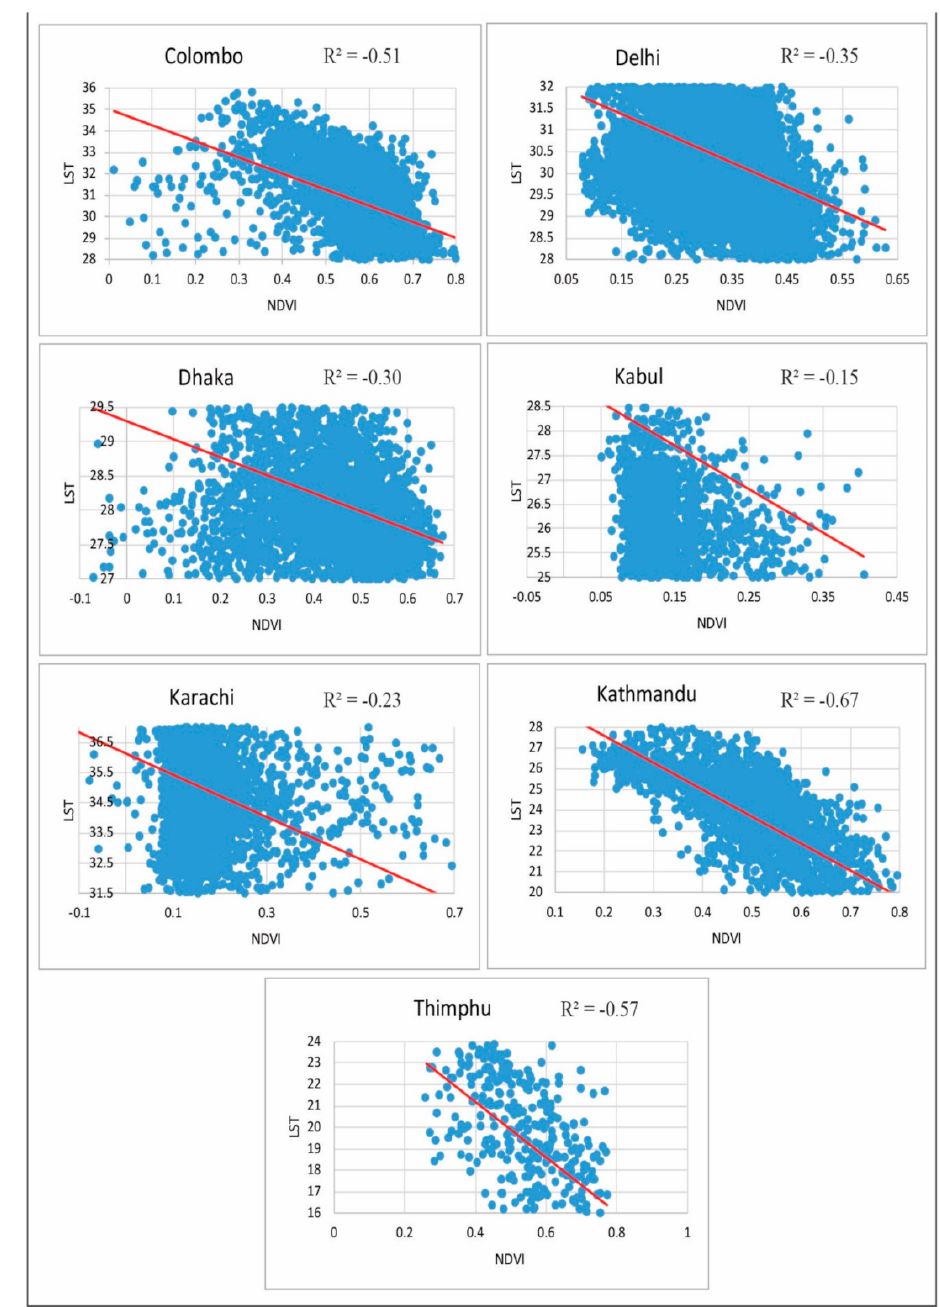
Figure 8. Pearson Correlation Scatter Plots of SA